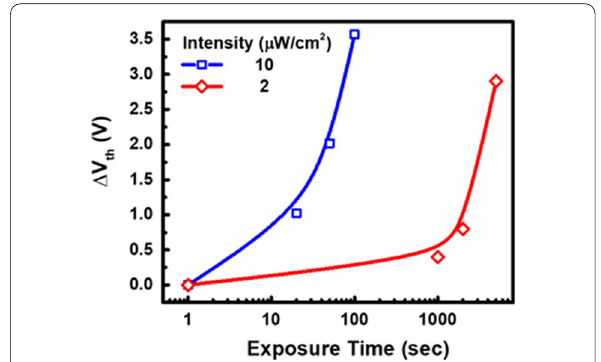
Fig. 10 The photo‑response of the micro‑detector with exposure time under different EUV intensity